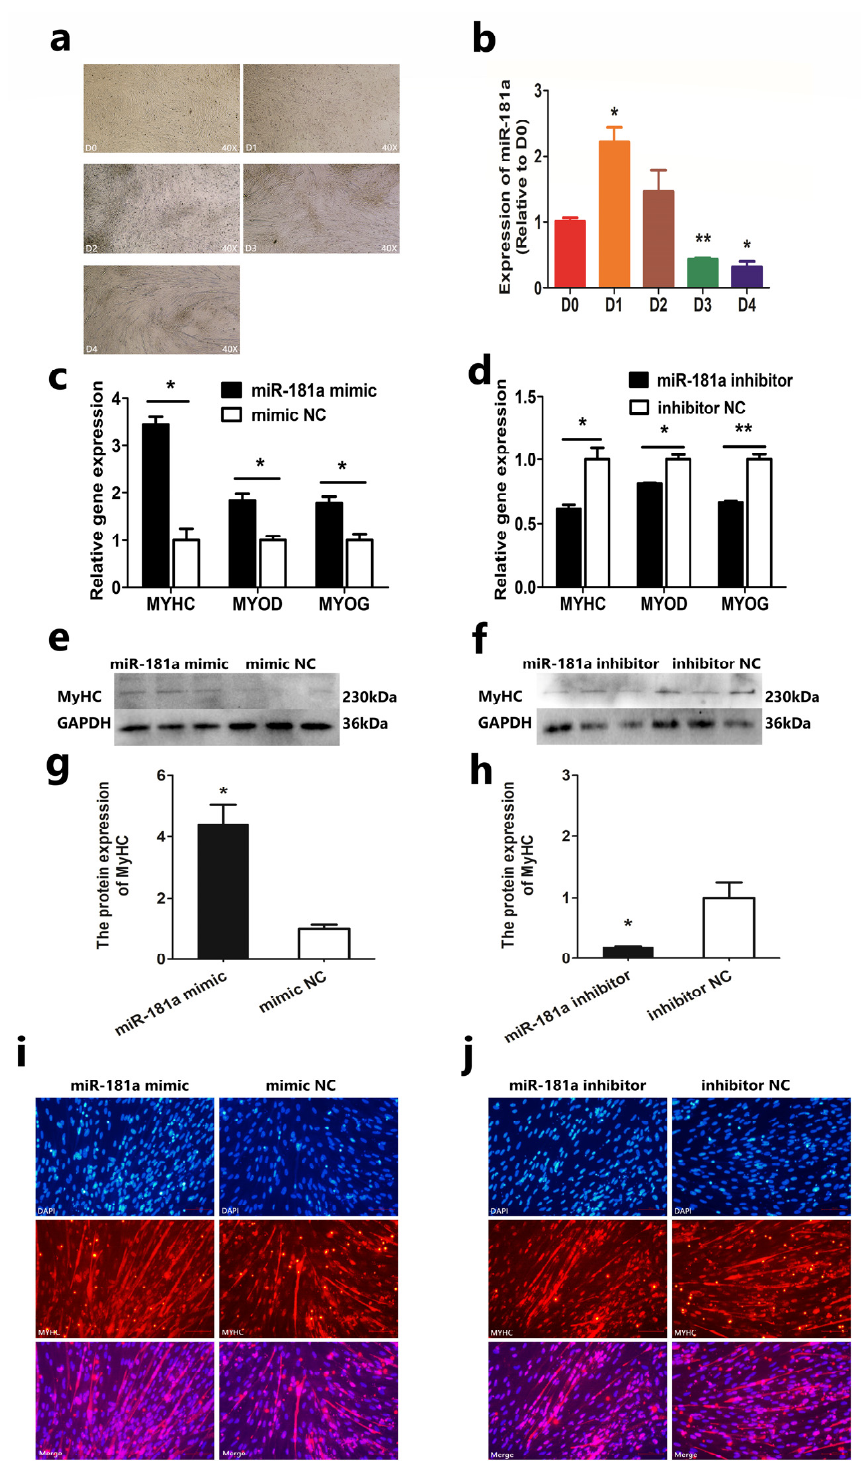
Figure 2. MiR-181a facilitates SMSCs differentiation in Hu sheep: ( a ) Differentiation images of SMSCs in vitro; ( b ) The relative expression of miR-181a during SMSCs’ differentiation (DM0-DM4 represents differentiation from zero to four days); ( c , d ) The relative mRNA expression of MyHC, MyoD, and MyoG; ( e , f ) The relative protein expression of MyHC; ( g , h ) Statistical analysis of ( e , f ); ( i , j ) Immunofluorescence staining of SMSCs. The magnification is 100 times. In all graphs, all data are presented as means ± SEM (standard error of the mean) ( n = 3). Statistical significance was performed by unpaired Student’s t -test. (* p < 0.05; ** p < 0.01) vs. NC (negative